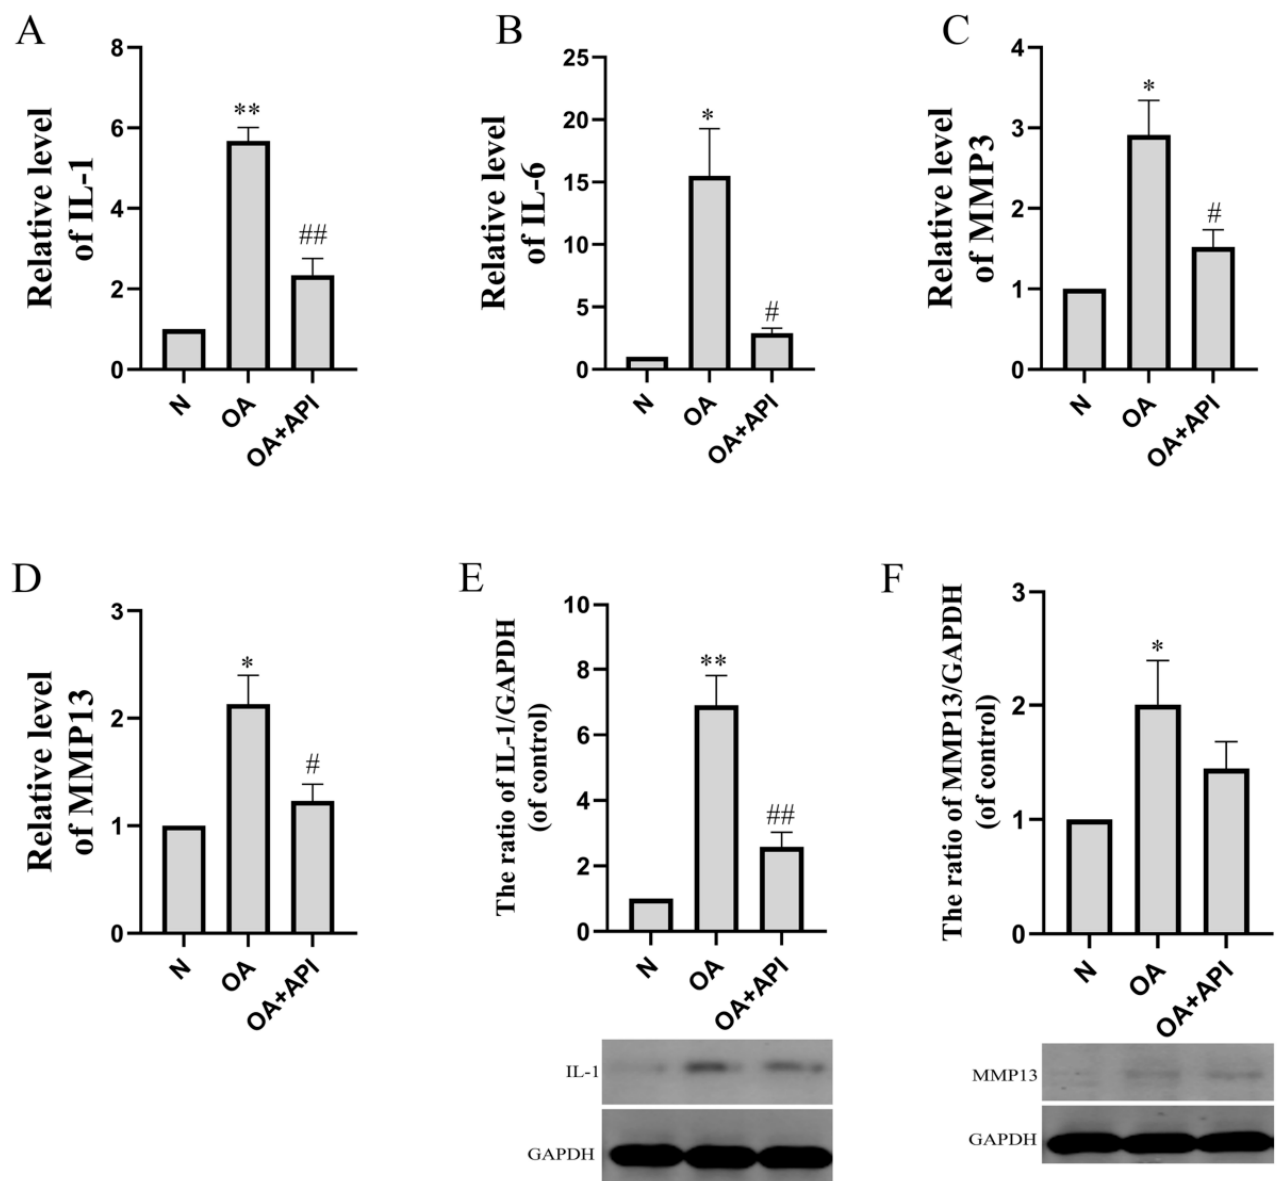
Figure 3. The effect of apigenin on the levels of inflammation-related mRNA and proteins of chondro- cytes in OA mice. Relative quantities of inflammation-related genes are expressed as fold differences compared to the control. ( A ) IL-1, ( B ) IL-6, ( C ) MMP3, ( D ) MMP13, ( E ) IL-1 protein level, and ( F ) MMP13 protein level. Above, densitometric analysis; below, representative images of im- munoblots. Data are the mean ± SD of the mean (n = 3). * p < 0.05 versus normal group (N); ** p < 0.01 versus normal group (N); # p < 0.05 versus OA group; ## p < 0.01 versus OA group.